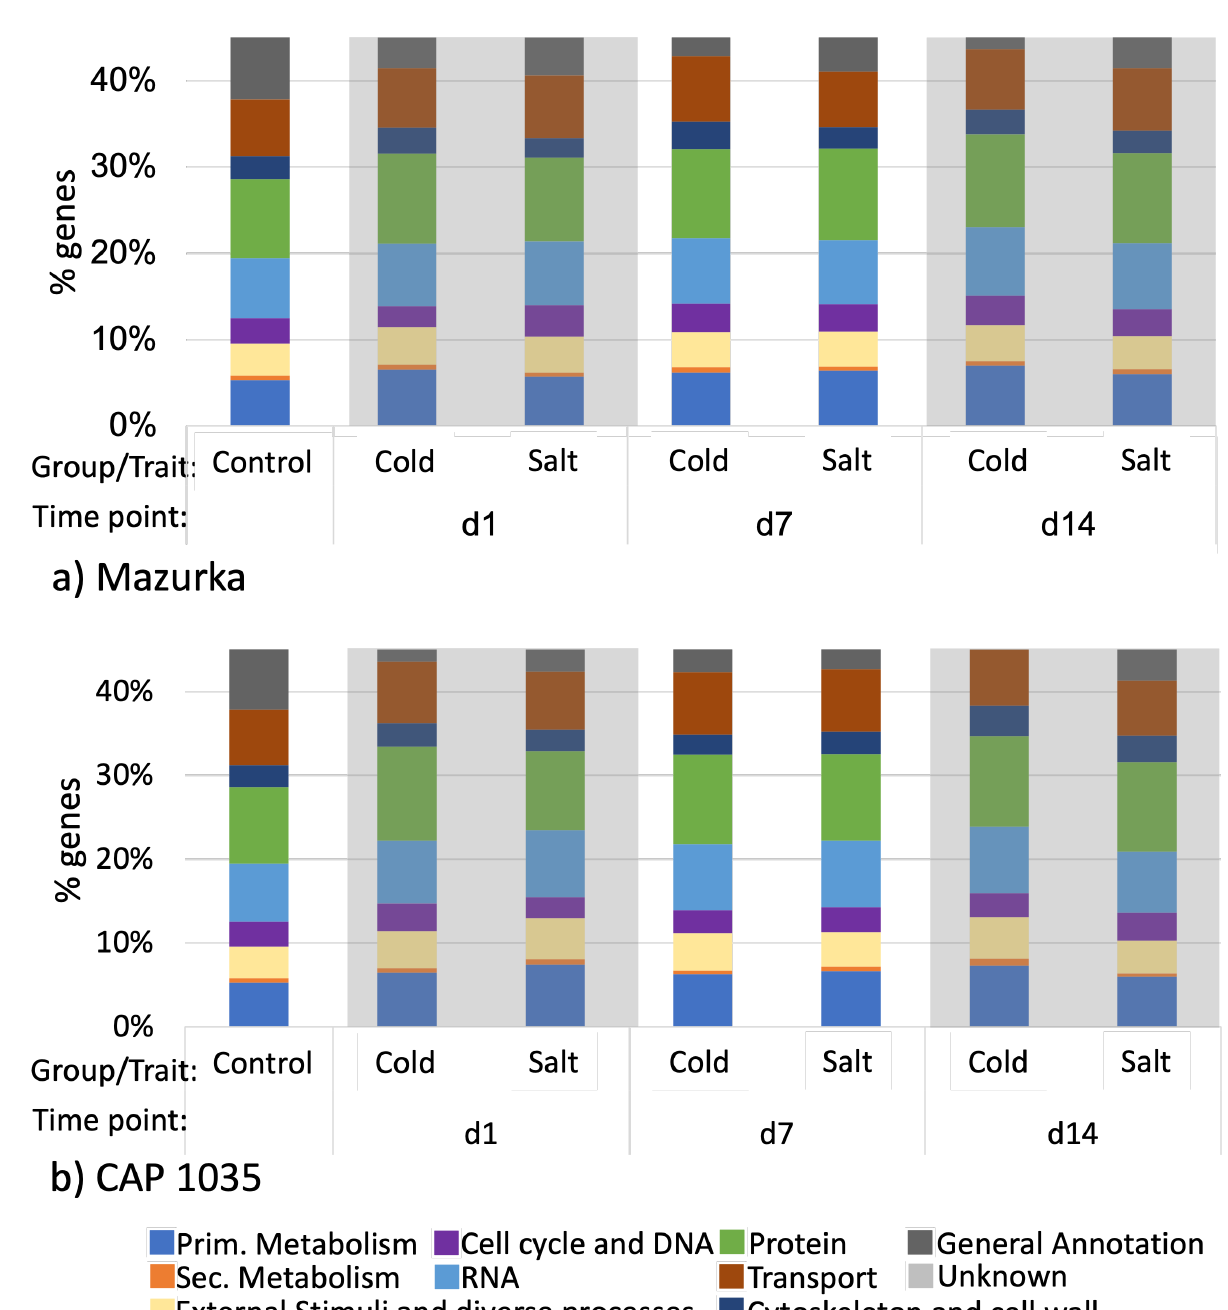
Figure A11. Functional characteristics of genes in significant modules of WGCNA for both species. Co-Expression analysis (WGCNA , Ref. [66]) was performed for both transcriptomes individually with all samples from the harvest time point as indicated (data for Mazurka is shown in ( a ), data for CAP1035 in ( b )). Within the significant modules, all genes were characterized and summarized according to their biological function of indicated Mercator bins [71]. Not shown are 55% of the genes. Those belong to the categories “General Annotation” and “Unknown”.